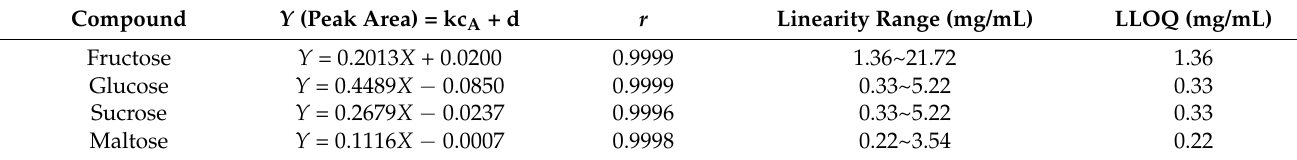
Table 5. qNMR ESM-based calibration function parameters for compounds, including regression equations, correlation coefficients ( r ) and linearity